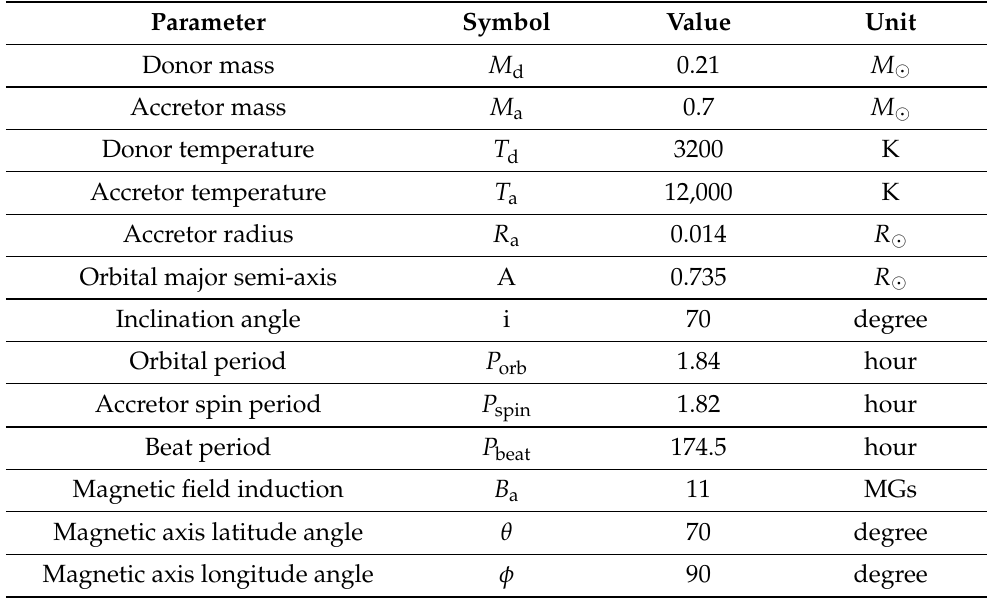
Table 4. Initial parameters for calculations of the asynchronous polar CD